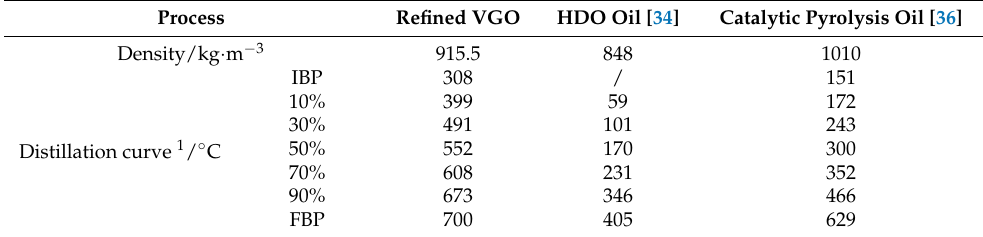
Table 1. Basic properties of refined VGO, HDO oil and catalytic pyrolysis oil.